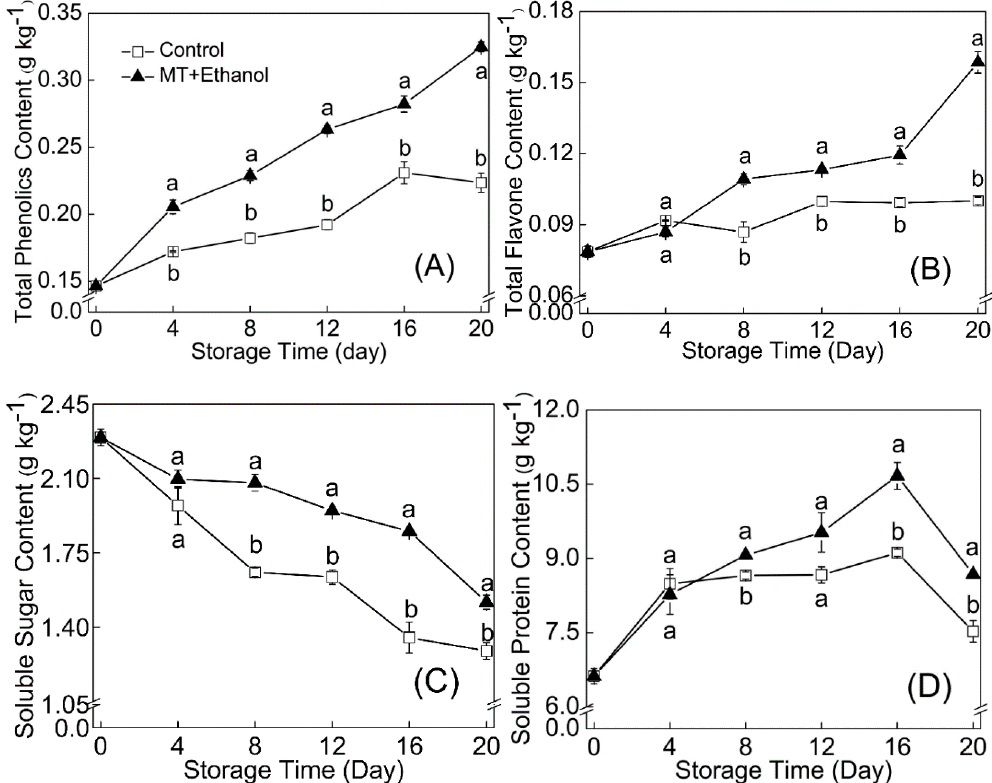
Figure 4. Effects of MT combined with ethanol treatment on total phenols ( A ), total flavonoids ( B ), soluble sugar ( C ), and soluble protein ( D ) contents. Results are expressed as mean ± SD of triplicate assays. Vertical bars represent the standard errors of the means. Significant differences ( p < 0.05) are represented by different letters.